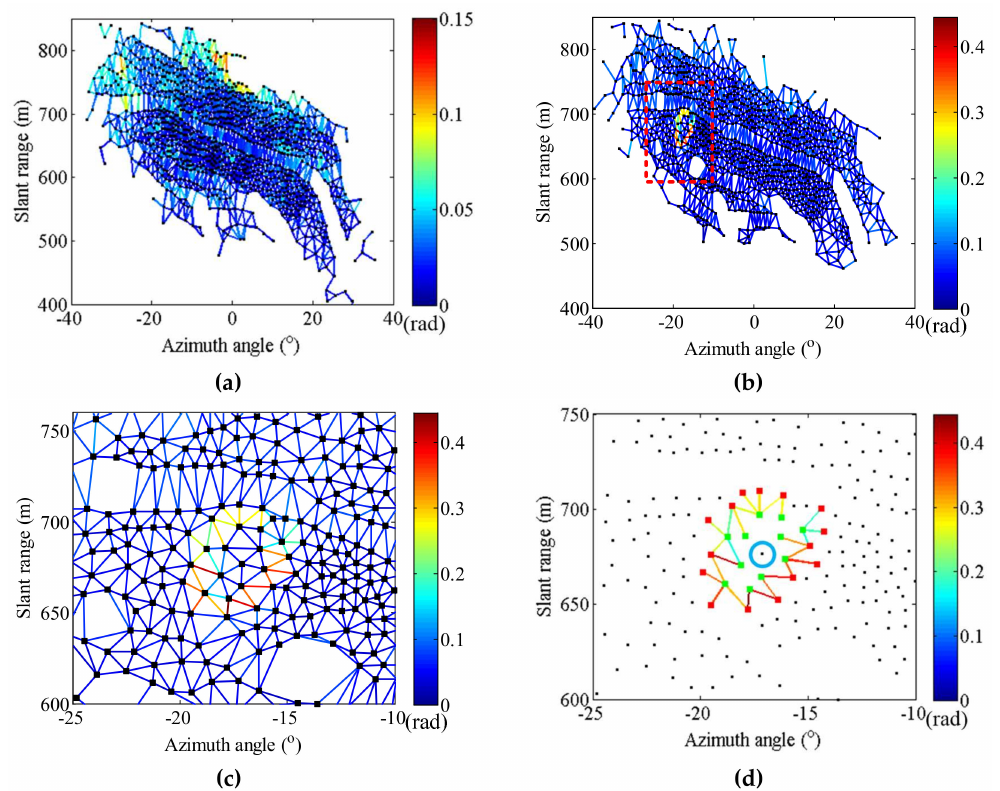
Figure 14. Triangulation network constructed with the cluster centers of ( a ) Group A and ( b ) Group B. ( c ) Enlarged map of the red dotted box in Figure 14b. ( d ) Clusters with large phase